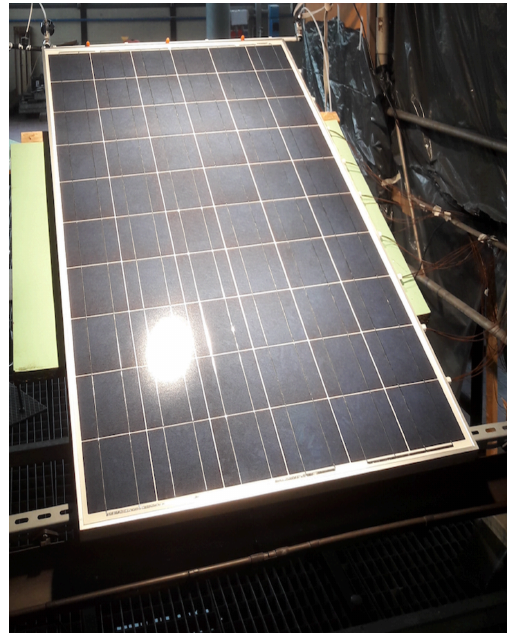
Figure 3. PV module installation. The module is fixed on a tilting desk.